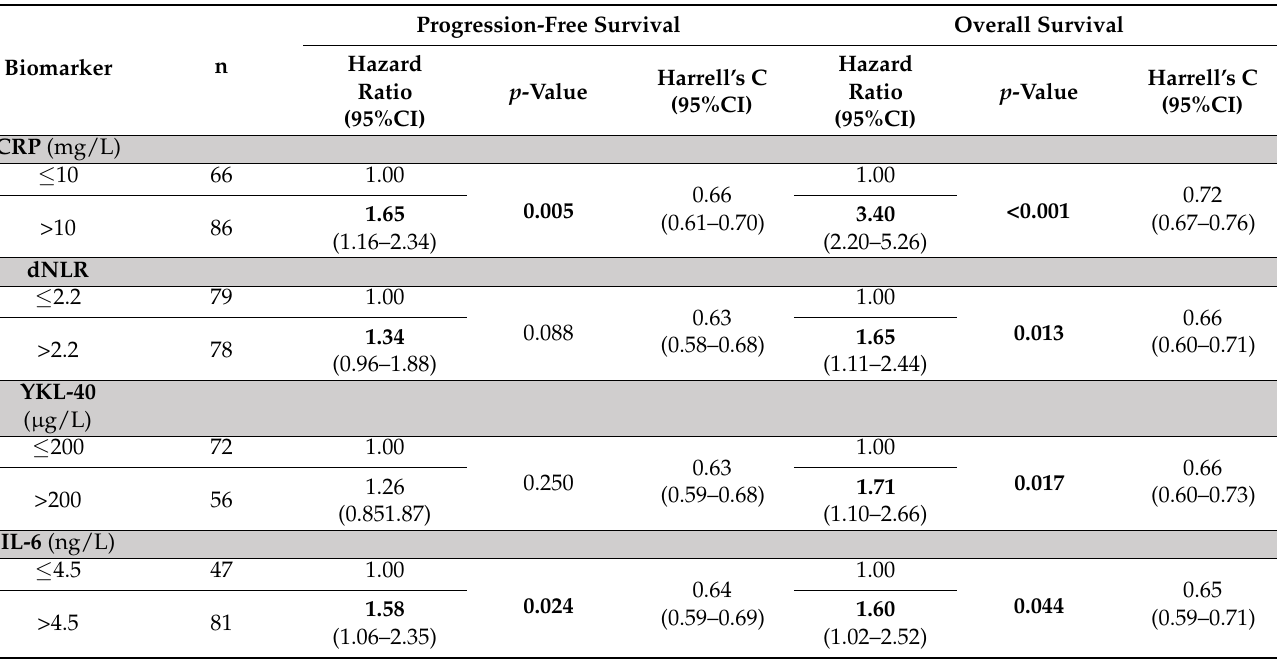
Table 3. Multivariate Cox analysis of inflammatory biomarkers and progression-free survival and overall survival adjusted for age, sex, treatment allocation, ECOG performance status, number of metastatic sites, and primary tumor in situ in the